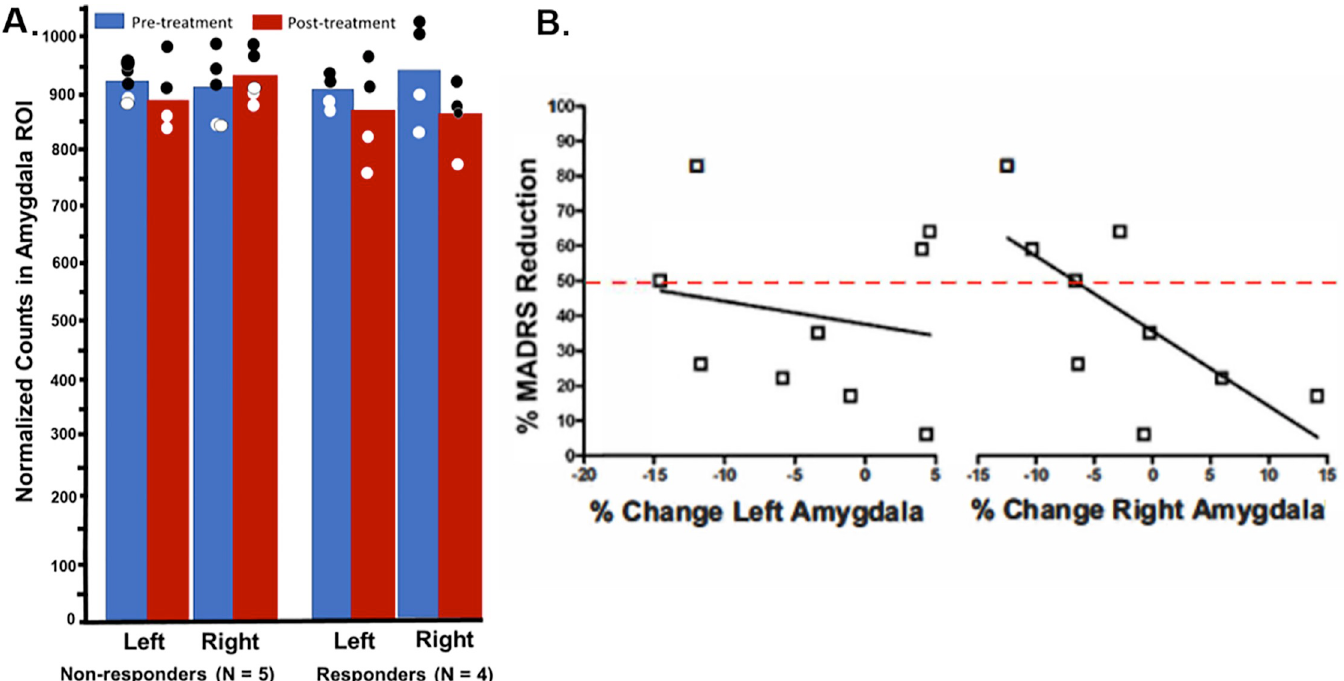
Fig 3. Changes in amygdala glucose uptake before and after treatment and its relationship to depression symptoms. (A) Amygdala metabolism examined separately for responders vs. non-responders in the right and left amygdala before and after treatment. Blue denotes pretreatment; red denotes post-treatment. (B) Correlation between percentage change in MADRS scores and change in amygdala metabolism. Only the right amygdala showed a significant correlation between change in metabolism and change in MADRS scores. Red line identifies threshold for